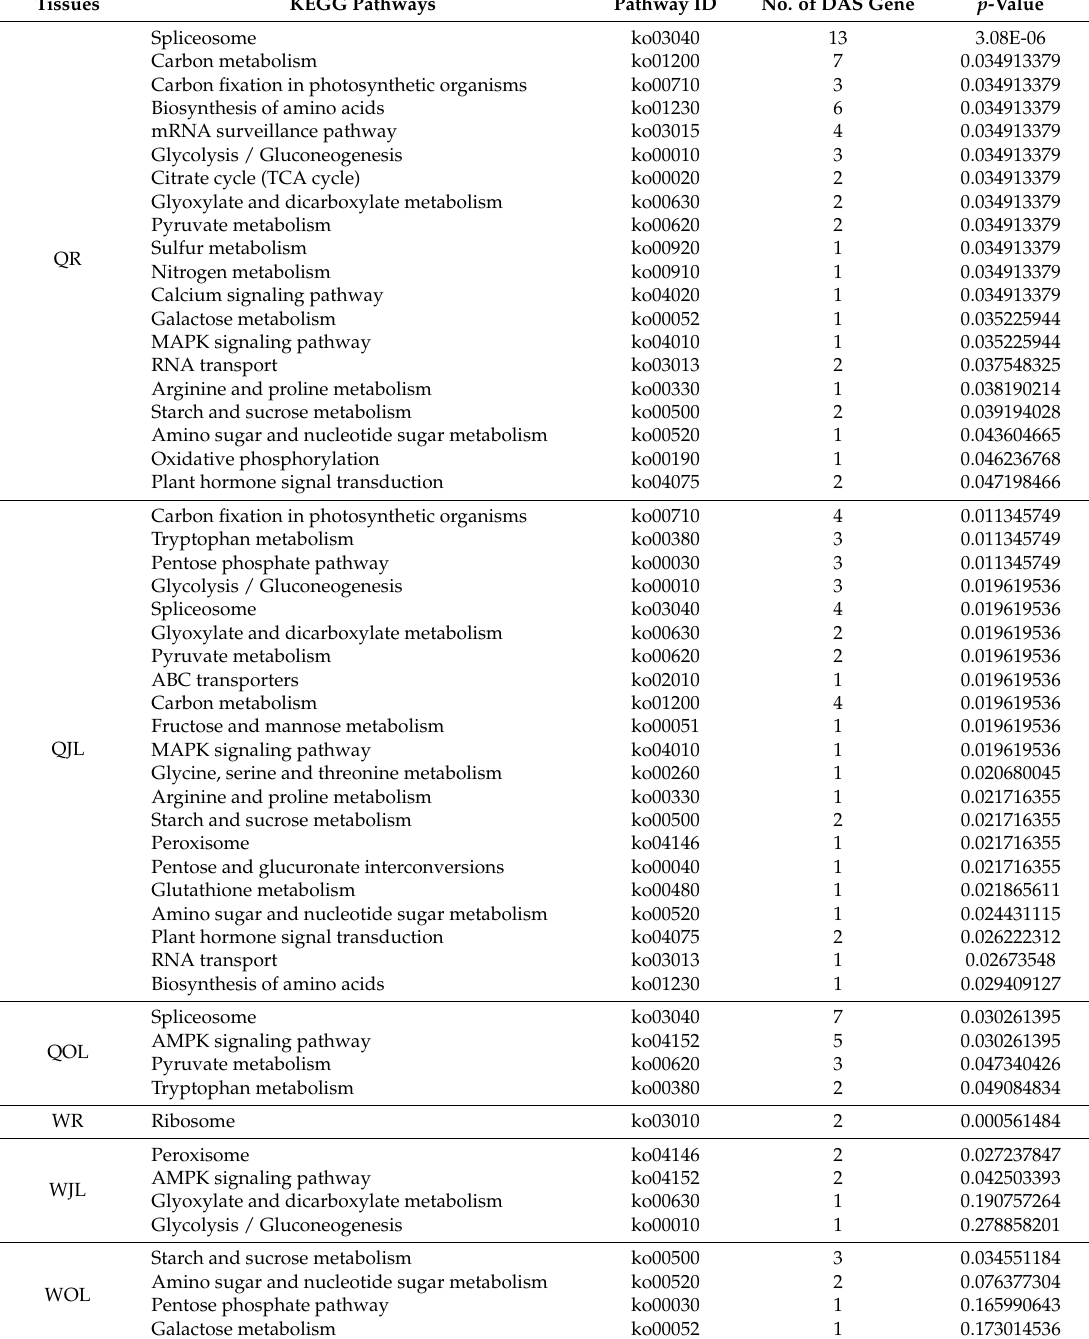
Table 4. KEGG pathways of differential alternative splicing genes in root, juvenile leaves and old leaves of B. napus cultivars Qingyou10 and Westar10 under B deficient